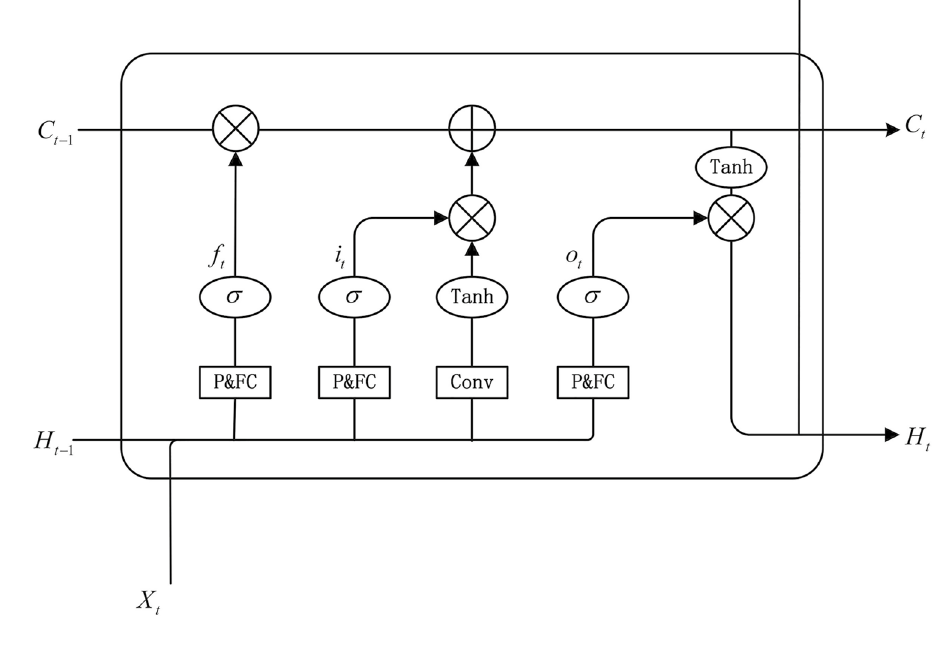
Fig. 3 GateConvLSTM